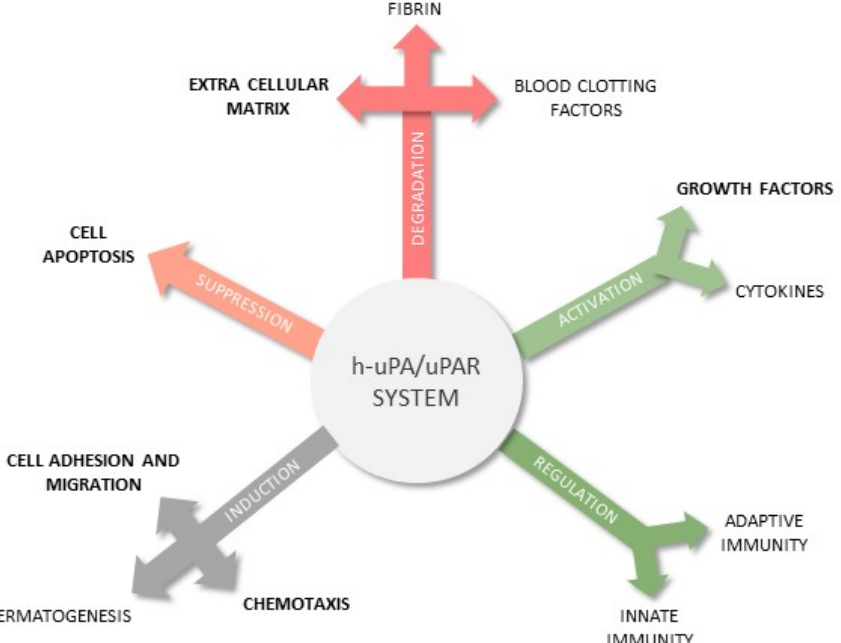
Figure 1. The main functions of the h-uPA/uPAR system in human physiology and its relation with cancer. with